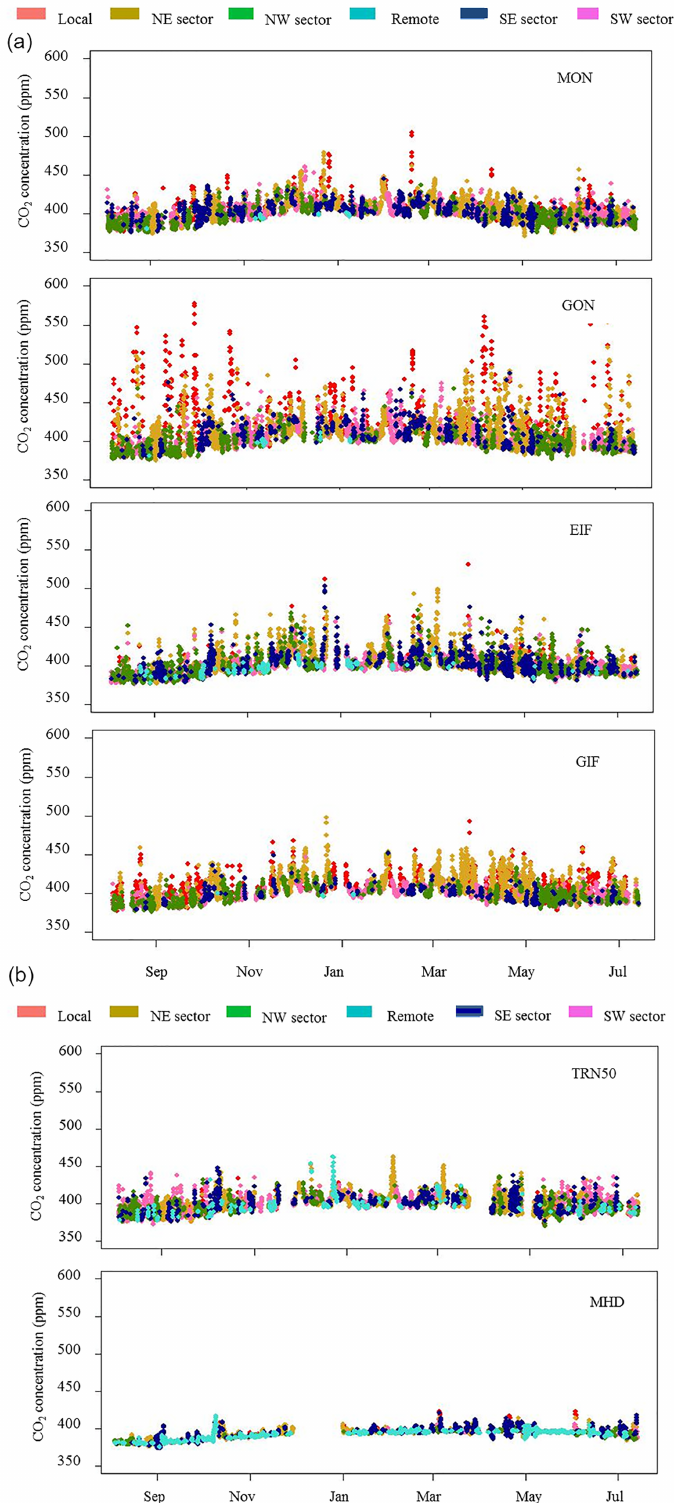
Figure 4. (a) Time series of CO 2 concentration (1h averages) recorded during the CO 2 -MegaParis period and colored by wind classed for sites MON (NE rural site, 9ma.g.l.), GON (peri-urban site, 4ma.g.l.), EIF (urban site, 317ma.g.l.) and GIF (SW peri-urban site, 7ma.g.l.). (b) Time series of CO 2 concentration (1h averages) recorded during the CO 2 -MegaParis period and colored by wind classed for sites TRN50 (rural SW, 50ma.g.l.) and MHD (coastal remote site, 15m